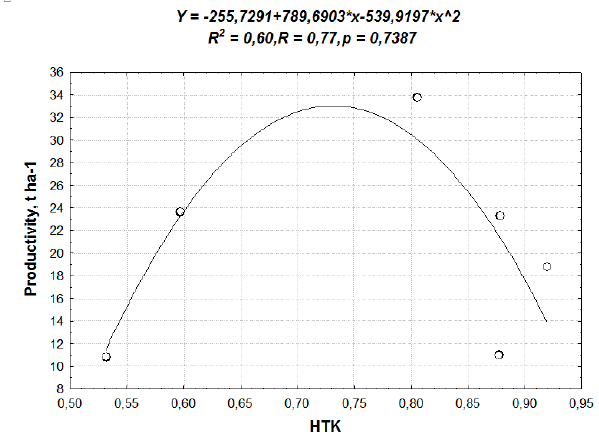
Figure 3. Dependence of lovage green mass productivity on the hydrothermal coefficient (2011-2016) The determination coefficient is considerable (R 2 =0.60), and the coefficient of the multiple correlation is high (R=0.77),